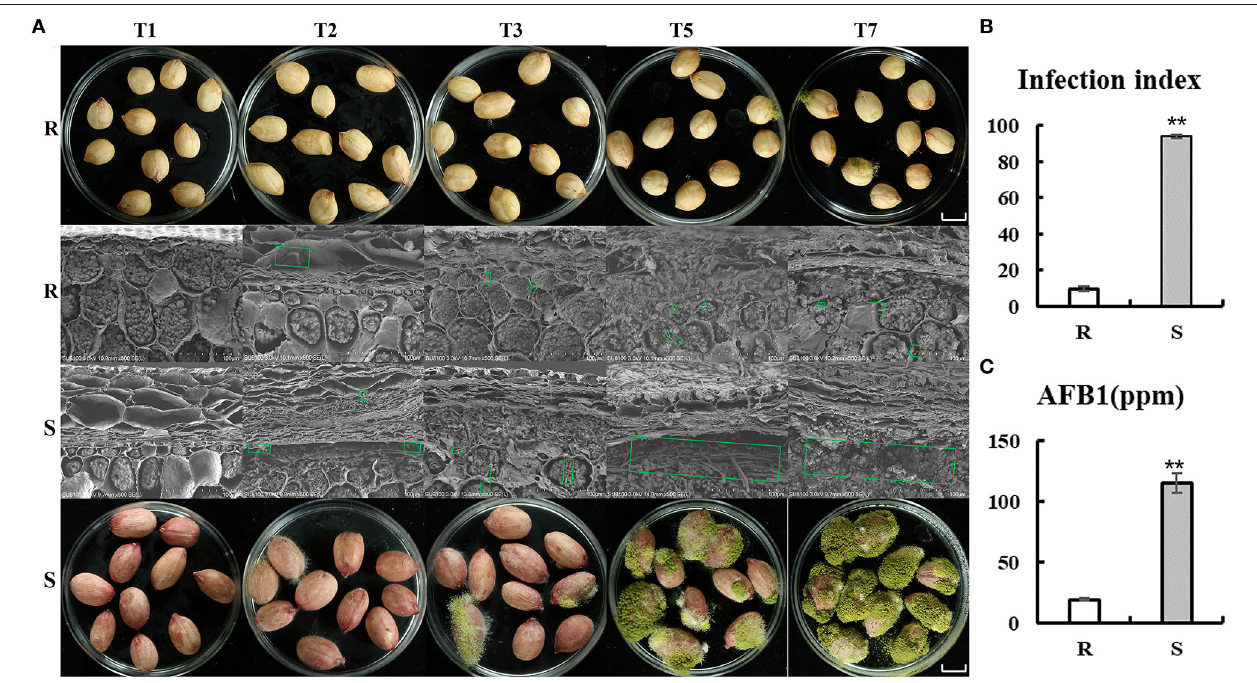
FIGURE 1 | Comparison of R and S on the phenotypes of peanut seeds responding to A. flavus . (A) Mycelia growth on peanut seeds at different inoculation processes (T1, T2, T3, T5, and T7). Bars = 1cm. (B) Infection index and aflatoxin B1 (AFB1) content (C) of the R and S genotypes after inoculation of A. flavus for 7 days. Green box shows mycelial of Aspergillus flavus L. Error bars indicated ± standard errors (SEs) of three independent biological replicates ( n = 3). ** P < 0.01 ( t -test) compared with R